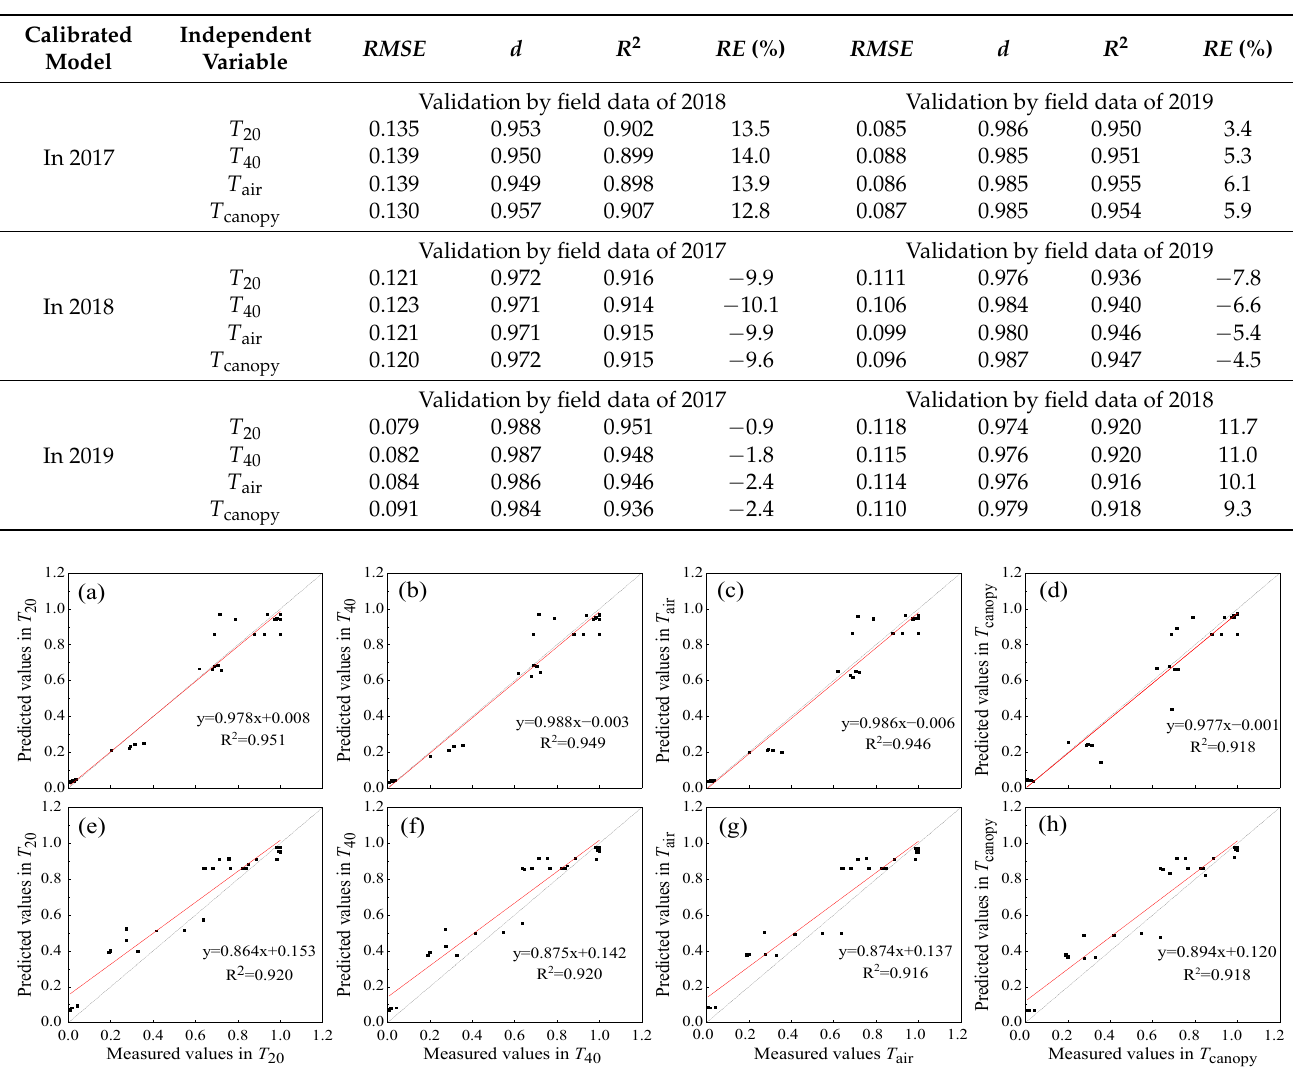
Figure 15. Regressions between the predicted and measured values of RFBA in 2017–2018 using the NR-logistic models calibrated in 2019 with four inputs: ( a ) T 20 , ( b ) T 40 , ( c ) T air , ( d ) T canopy , in 2017; ( e ) T 20 , ( f ) T 40 , ( g ) T air , ( h ) T canopy , in 2018.